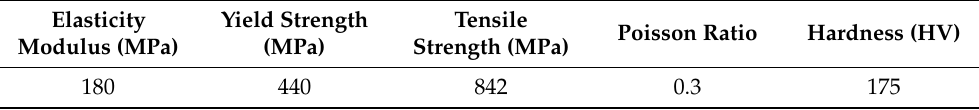
Table 2. Mechanical properties of Haynes 230.